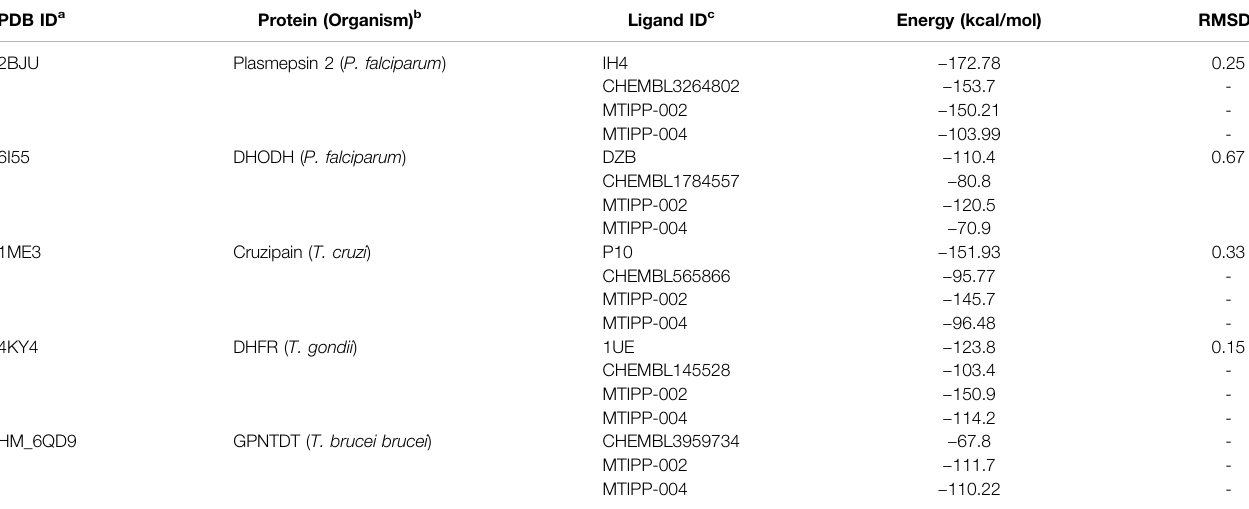
TABLE 5 | Results from the docking